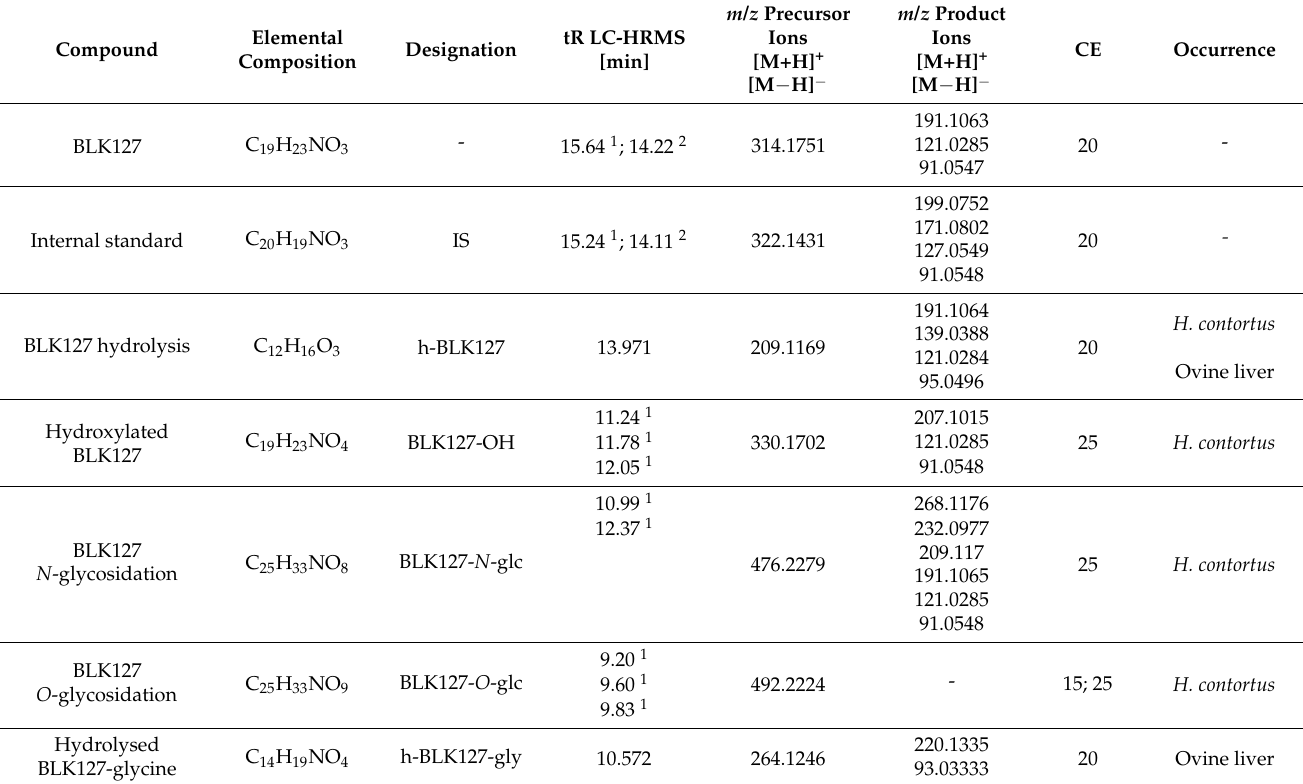
Figure 8. The proposed metabolic pathways of compound BLK127 in the ovine liver. The detailed information (elemental composition, designation, m / z of precursor and product ions, collision energy (CE), t R about BLK127, the IS, and the metabolites detected in H. contortus , PCLS and isolated hepatocytes) are given in Table 2. Table 2. List of the main metabolites of BLK127 detected in H. contortus adults and in the ovine liver, their elemental composition, designation, retention times (t R ), m / z of the precursor and product ions, and collision energy (CE) detected by LC-HRMS. The table includes the parent drug BLK127 and the internal standard (IS)